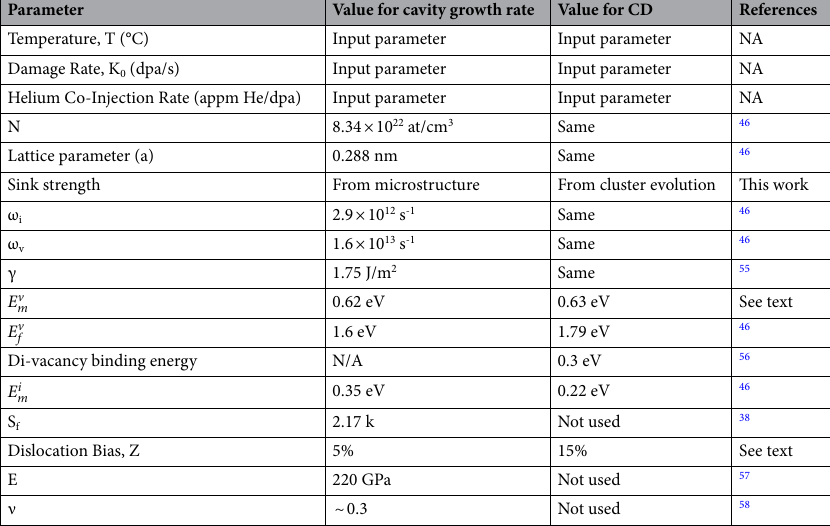
Table 3. Table of input parameters for calculating the cavity growth rate equation and CD when different from the cavity growth rate input